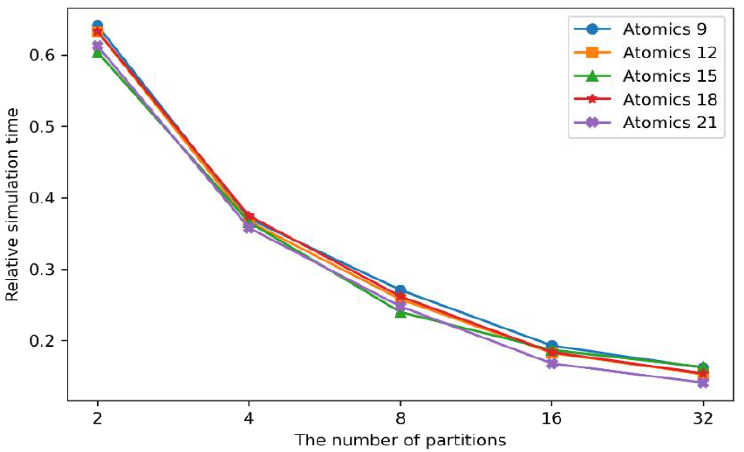
Figure 13. The experimental results by the atomic data sizes and the number of partitions.